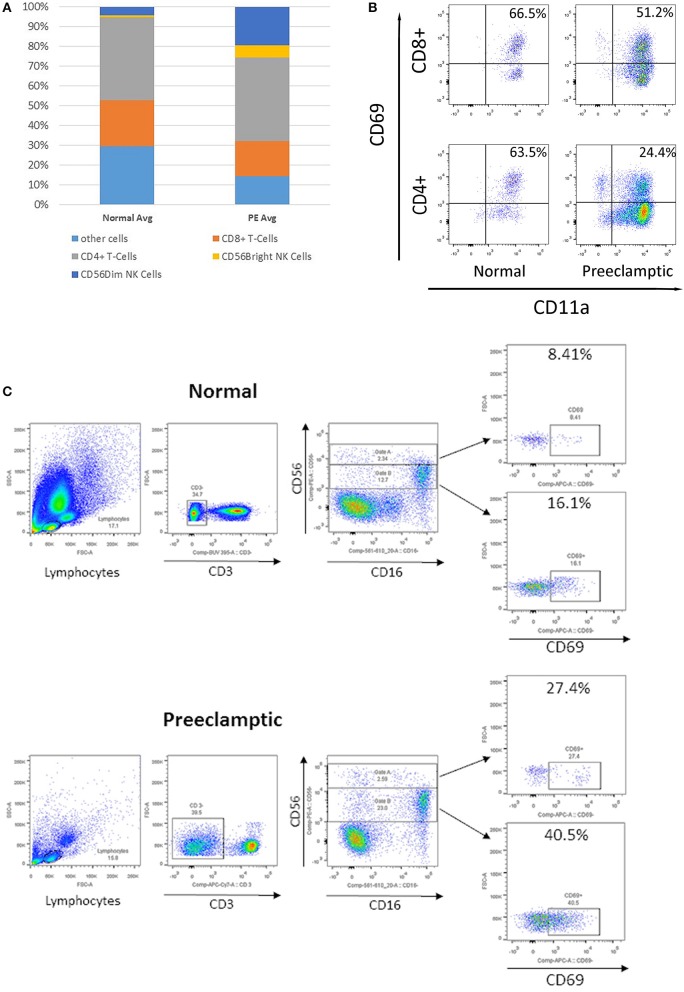
Flow cytometry analysis of peripheral immune cells in blood from normotensive control and pre-eclampsia (PE) women taken before delivery. (A) The relative proportion of T cells and natural killer (NK) cells. (B) Flow cytometry analysis of CD69+, CD11a+, CD8+, and CD4+ T cells. (C) Analysis of CD3–, CD56+, and CD16+ NK cells, divided into CD56 Bright (Gate A) and Dim NK cells (Gate B), and early activation CD69+.